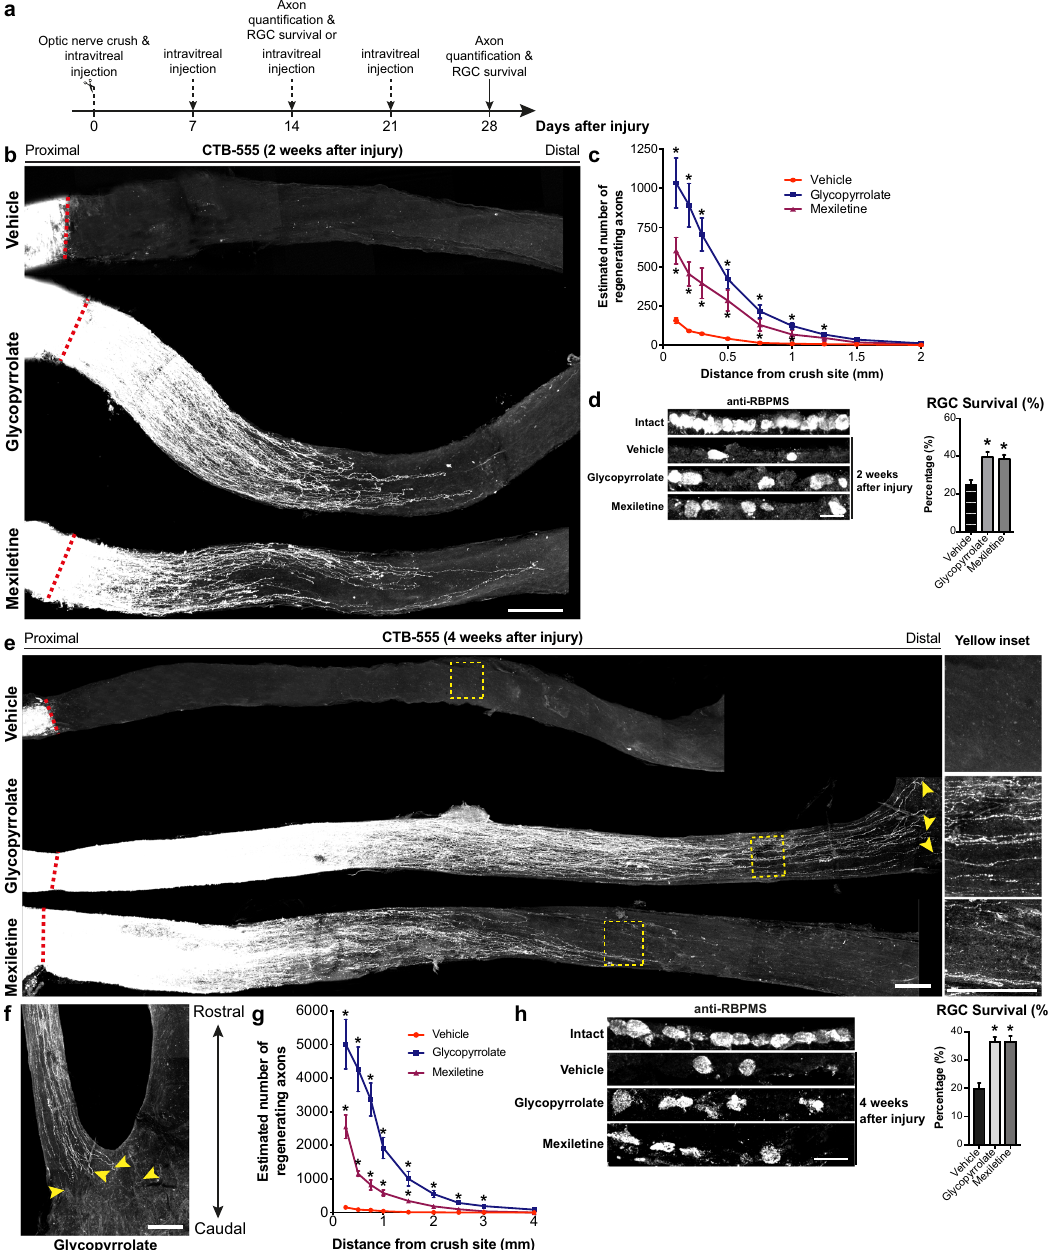
Fig. 7 FDA-approved small molecules induce sustained and long-distance axon regeneration after optic nerve crush (ONC). a Schematic diagram illustrating the glycopyrrolate (1 µg) and mexiletine (1 µg) treatment paradigm for ONC. Axon regeneration was analyzed by cholera toxin subunit B-555 (CTB-555) tracing. b Robust axon regeneration was observed in glycopyrrolate-treated and mexiletine-treated mice at 2 weeks after ONC. c Glycopyrrolate and mexiletine induced more than 17-fold and 6-fold increase in the number of CTB-labeled regenerating axons extending 1.0 mm from the site of injury. d Serial transverse cryosections (20µm-thick) of retinae were immunostained with anti-RBPMS antibodies for retinal ganglion cell (RGC) survival assay. RBPMS-positive RGCs were counted in every fi fth section per retina (3 – 5 sections). RGC survival rate of small-molecule treatment groups nearly doubled after injury, when compared with vehicle control group. e Sustained long- distance axon regeneration was observed in glycopyrrolate-treated mice at 4 weeks after ONC, and some CTB-labeled axons regenerated along the whole length of the optic nerve to reach the optic chiasm in glycopyrrolate-treated mice [yellow insets in ( e )]. f Arrowheads indicated CTB-labeled regenerating axons projecting into the optic chiasm in glycopyrrolate-treated mice at 4 weeks after ONC. g At 2 mm distal to the lesion site, glycopyrrolate treatment resulted in more than 70-fold increase in the number of CTB-labeled regenerating axons, while up to 24-fold more regenerating axons were seen in mexiletine treatment group, compared with vehicle controls. h At 4 weeks after ONC, both glycopyrrolate and mexiletine induced a similar increase in RGC survival promoting effects, when compared with vehicle-treated controls. Scale bars: 200 µm in ( b , e ), 100 µm in ( f ), 20 µm in ( d , h ). Mean ± SEM ( n = 6 – 8 per group); * P < 0.05; one-way ANOVA followed by post hoc Bonferroni test in ( c , d , g , h